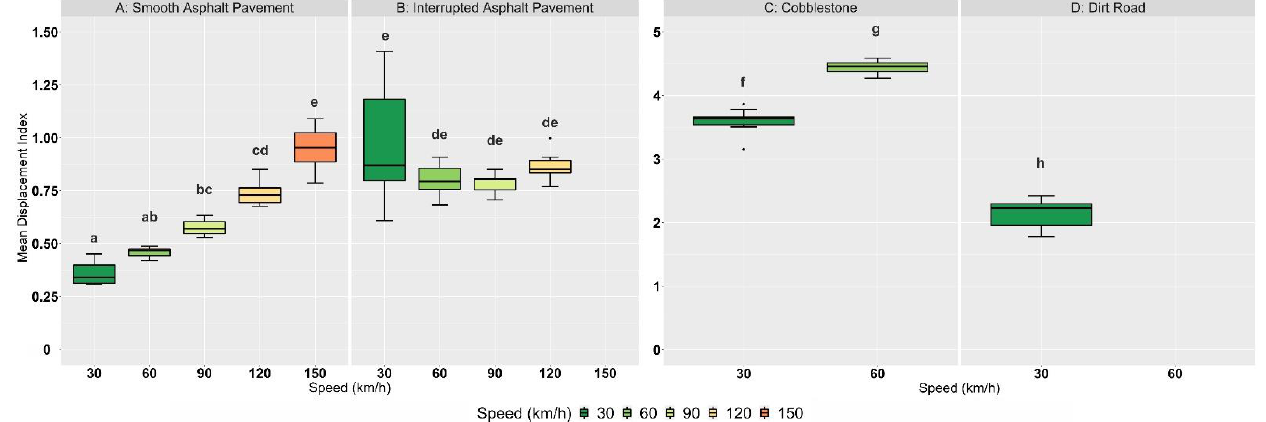
Figure 3. Summarized D x ̅ -values (mean Displacement Index D i for t = 60 s) from standardized road trials with one box per category ( n = 120, 10 each category). Highest and lowest values are shown as whiskers, inter-quartiles between quartiles 1 and 3 depicted as boxes with a median line. Outliers draw dots. a-h: boxes with different letters differ significantly ( p < 0.05).